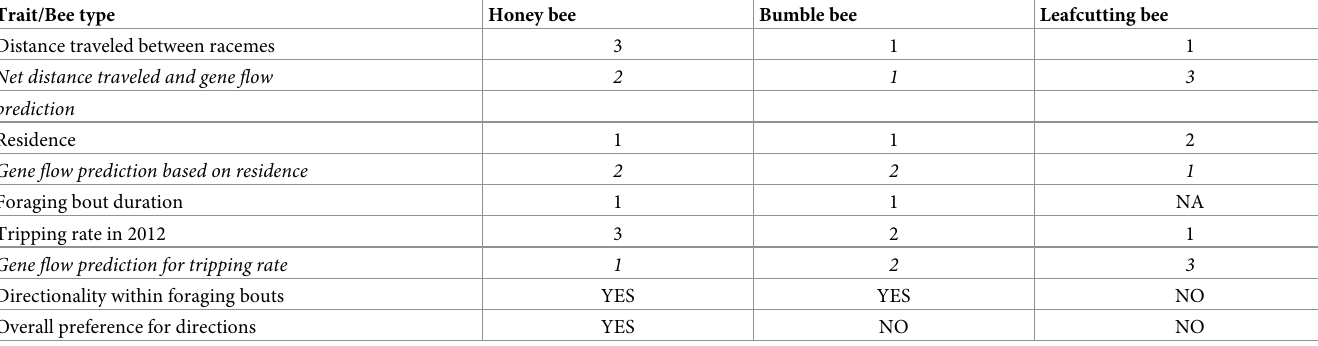
Gene flow predictions are italicized and presented for net distance traveled, residence and tripping